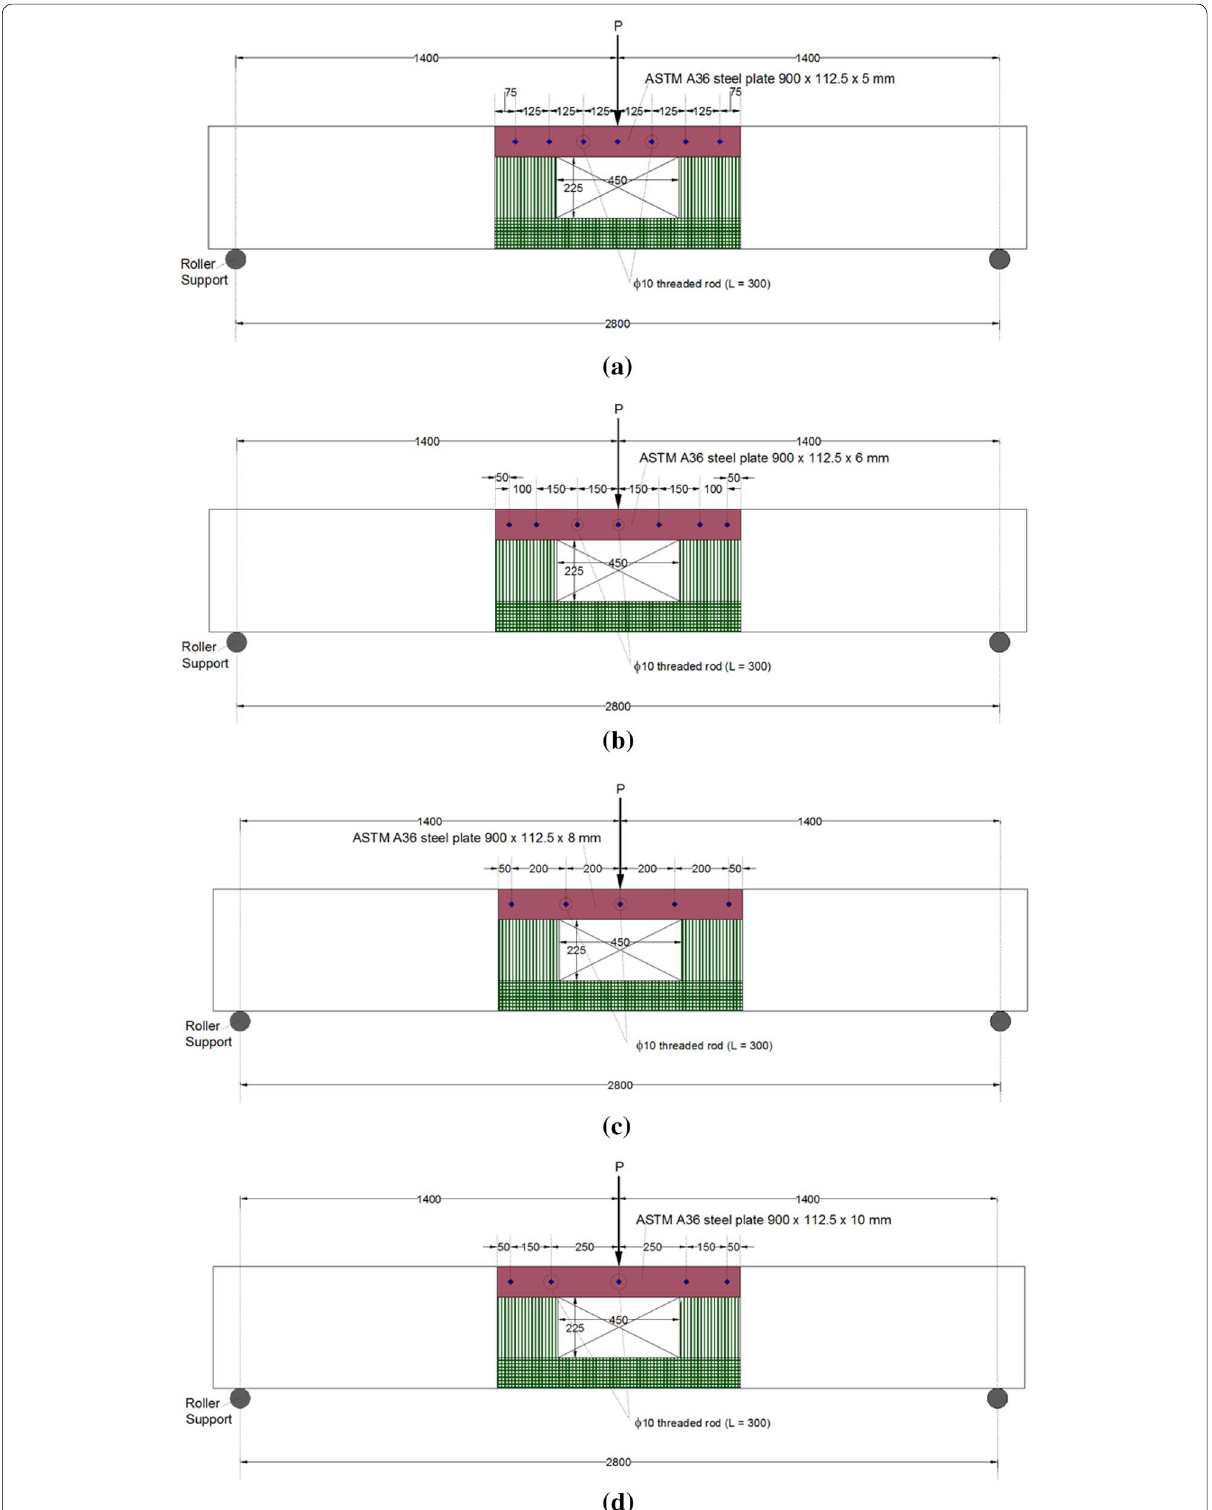
Fig. 16 Details of proposed strengthening schemes for beams with 450 mm opening (Note: all dimensions are in mm): a scheme‑3, b scheme‑4, c scheme‑5, and d